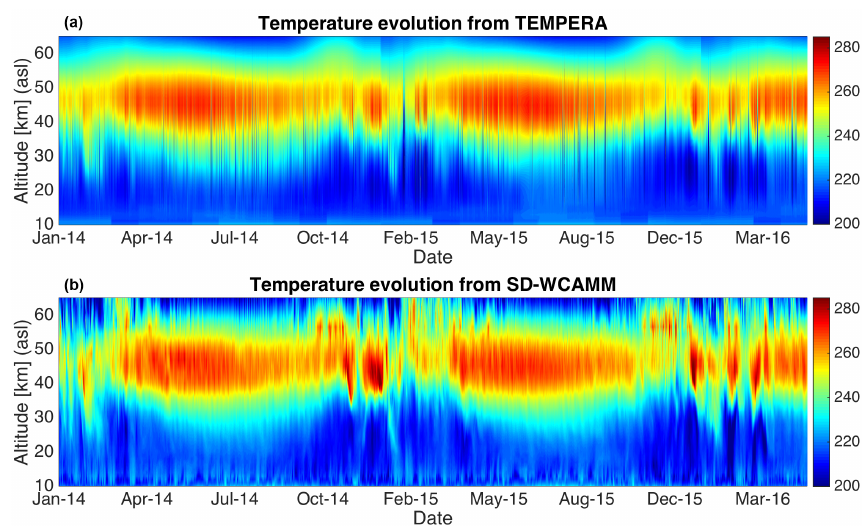
Figure 14. Stratospheric temperature from TEMPERA radiometer (a) and WACCM model (b) .